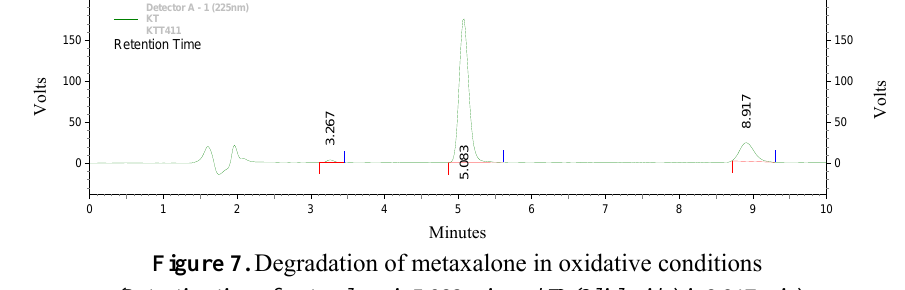
Figure 7. Degradation of metaxalone in oxidative conditions (Retention time of metaxalone is 5.083 min and IS (Gliclazide) is 8.917 min)